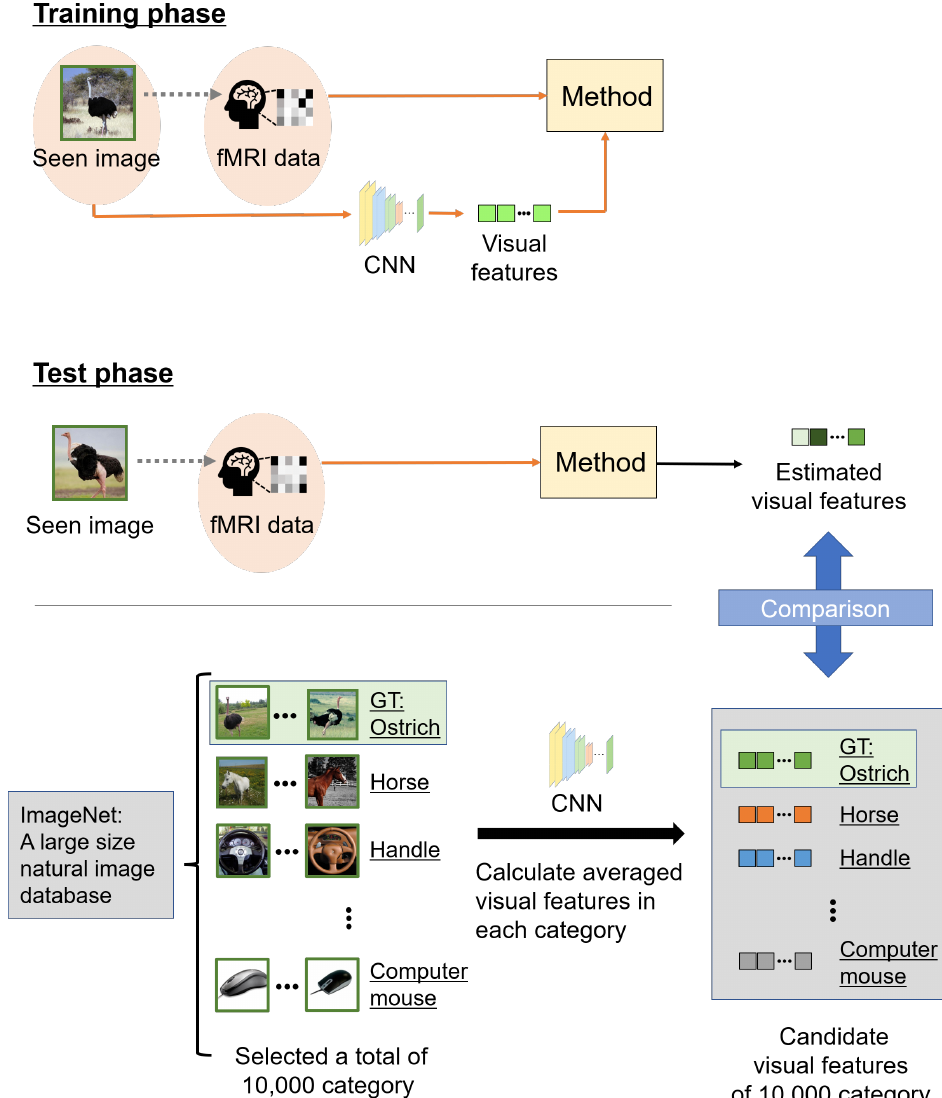
Figure 4. Overview of the scheme of category estimation. In the training phase, the relationship between a seen image and the corresponding fMRI data in each subject was learned. In the test phase, we estimated visual features using fMRI data based on the learned relationship. However, the visual features to be compared were computed from images chosen at random from ImageNet. These other images were 5–10 samples in each category, and we selected 10,000 categories from ImageNet. The 10,000 categories included 150 image categories belonging to the fMRI data in the test phase. We defined candidate visual features, averaged visual features, extracted from these other images in each category, and compared them with estimated visual features from fMRI data. Finally, we calculated the correlations between the estimated and candidate visual features, and the accuracy of the estimations was evaluated with the seen image category as the ground truth